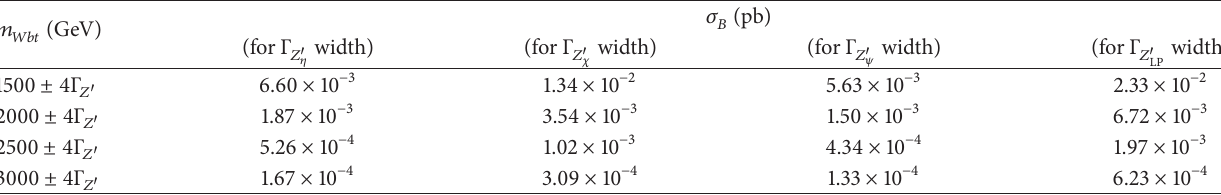
Table11:Thecrosssectionforthebackground( 𝜎 𝐵 )dependingonthevaluesofinvariantmassinterval.Thevaluesarecalculatedfortheprocess 𝑝𝑝 → (𝑊 + 𝑏𝑡 + 𝑊 − 𝑏𝑡)𝑋 at the LHC with √ 𝑠 = 13 TeV. The results are given in the invariant mass within 𝑀 for different 𝑍 󸀠 decay widths corresponding to the parameters explained in the text.